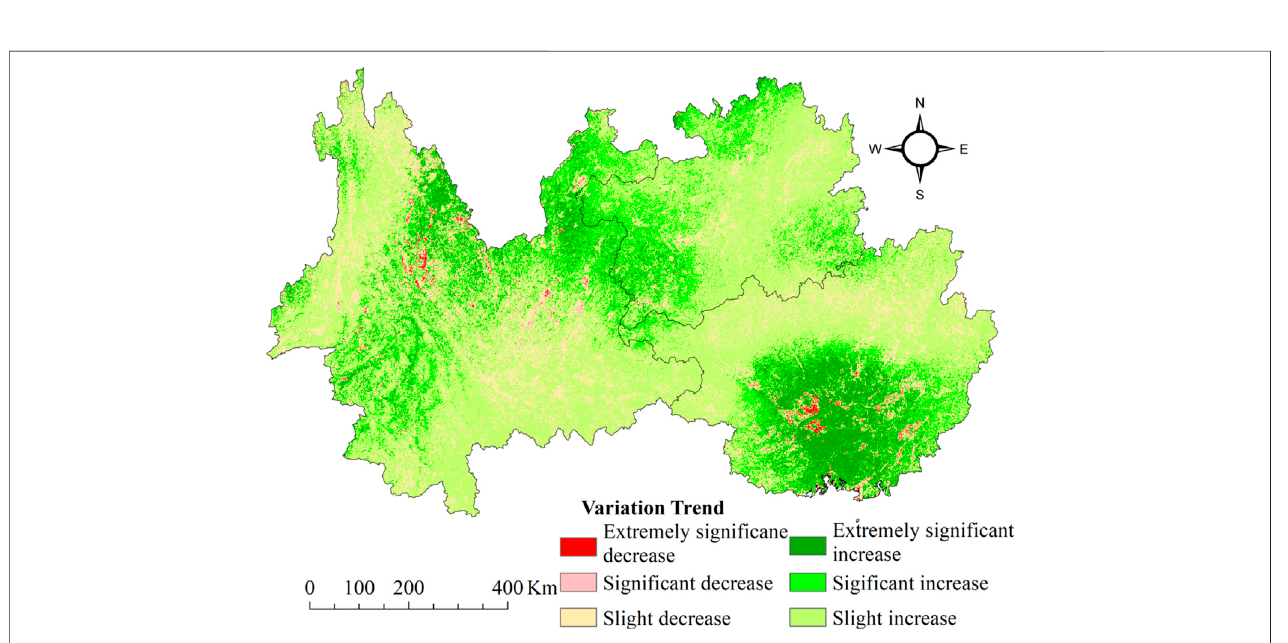
FIGURE 8 | The spatial distribution of the predicted NDVI variation trend in the three karst provinces of southwest China from 2001 to 2019.